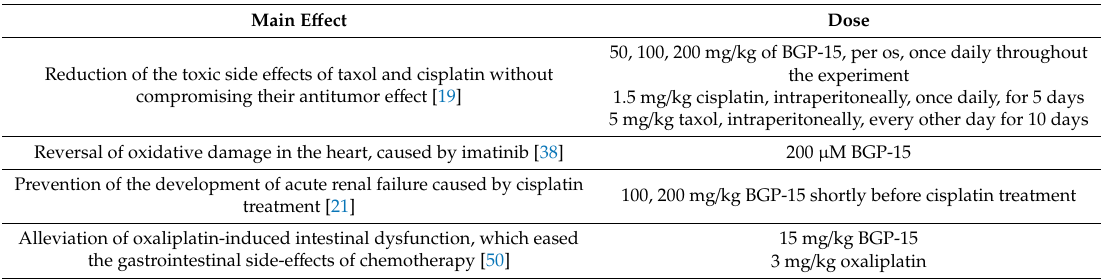
Table 4. Summary of the performed investigations related to the aforementioned e ff ects of BGP-15. Main E ff ect Dose